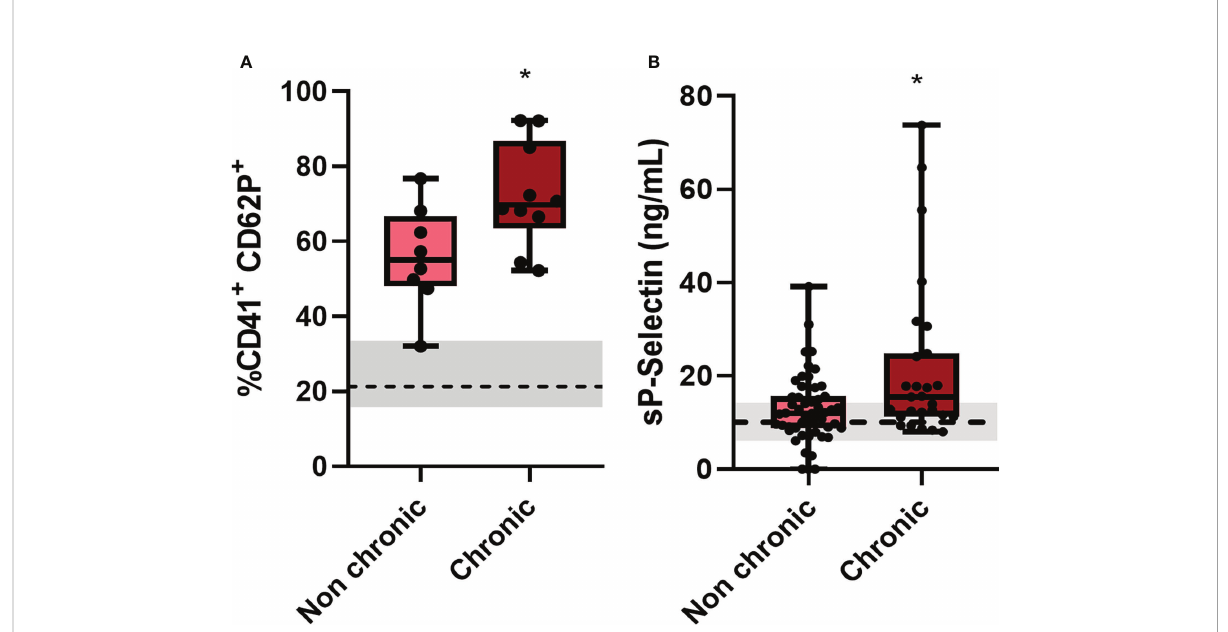
FIGURE 4 Patients who progressed to chronic conditions of CHIKV had greater platelet activation. (A) Patients who progressed to a chronic condition had higher expression of CD62P on the surface of platelets by fl ow cytometry, of the 25 patients analyzed, 8 did not progress to a conical condition and 10 became chronic, the other 7 did not have contact; and (B) Plasma quantitation of the soluble molecule of CD62P of patients who progressed to a chronic condition, of the 80 patients contacted, 51 did not progress to a chronical condition and 27 became chronic, the other 2 did not obtain quanti fi cation. *P ≤ 0.05 comparing non-chronic to chronic